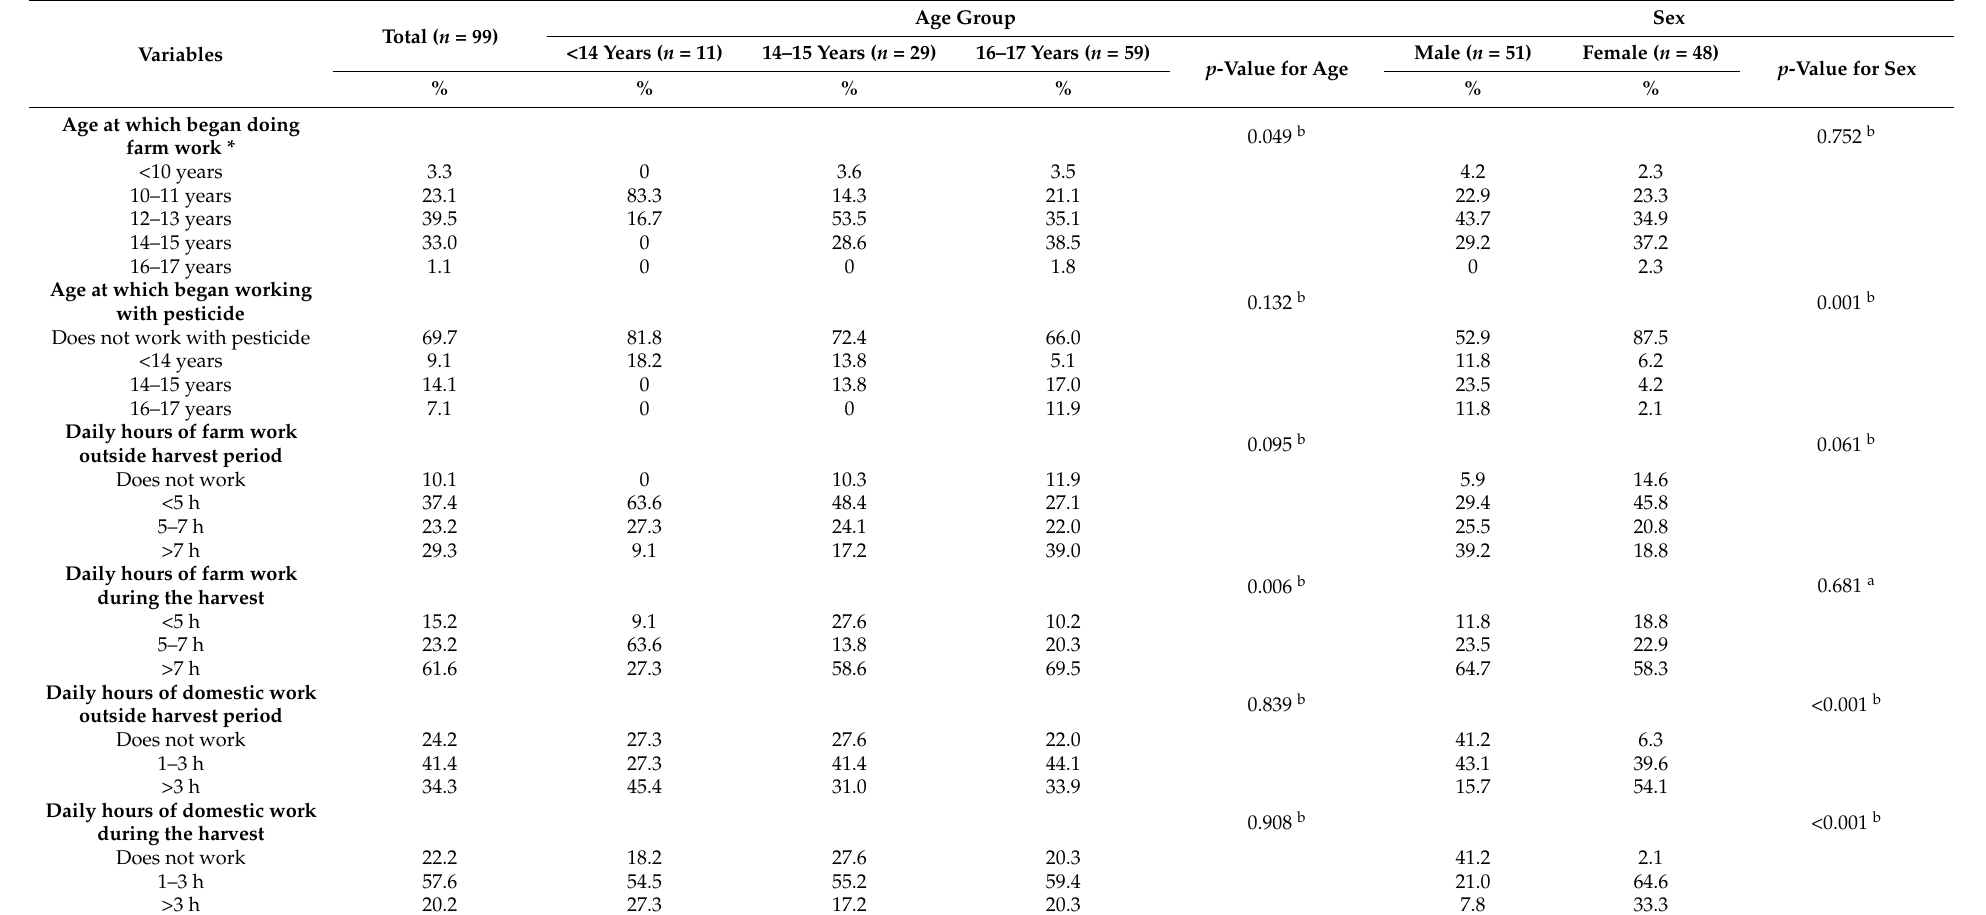
Table 2. Organization and division of tobacco farmers’ work, stratified by age and sex. S ã o Lourenço do Sul, Rio Grande do Sul, Brazil, 2011. ( n = 99).